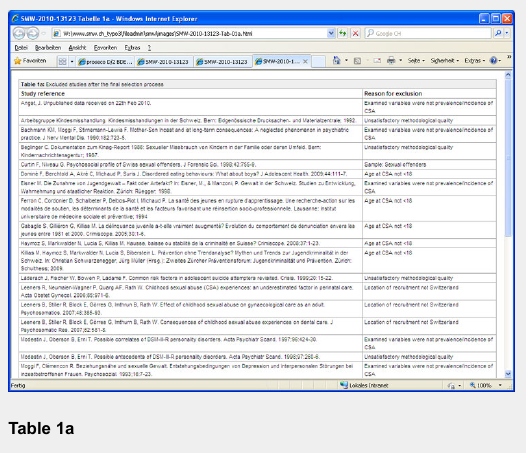
Excluded studies after the final selection